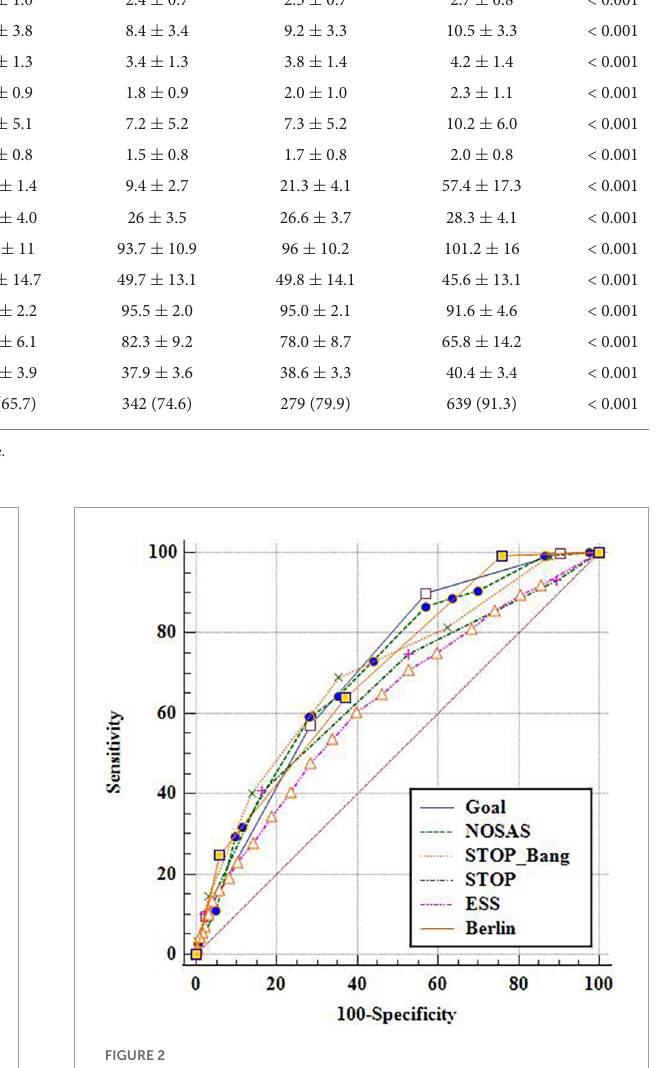
0.886, 0.422 to 0.349, and 0.843 to 0.398 respectively in three cut-off points. When the cut-off point of AHI was 5 events/h, the sensitivity of GOAL was the highest, while ESS and Berlin had higher specificity but lower sensitivity (see Tables 2 – 4